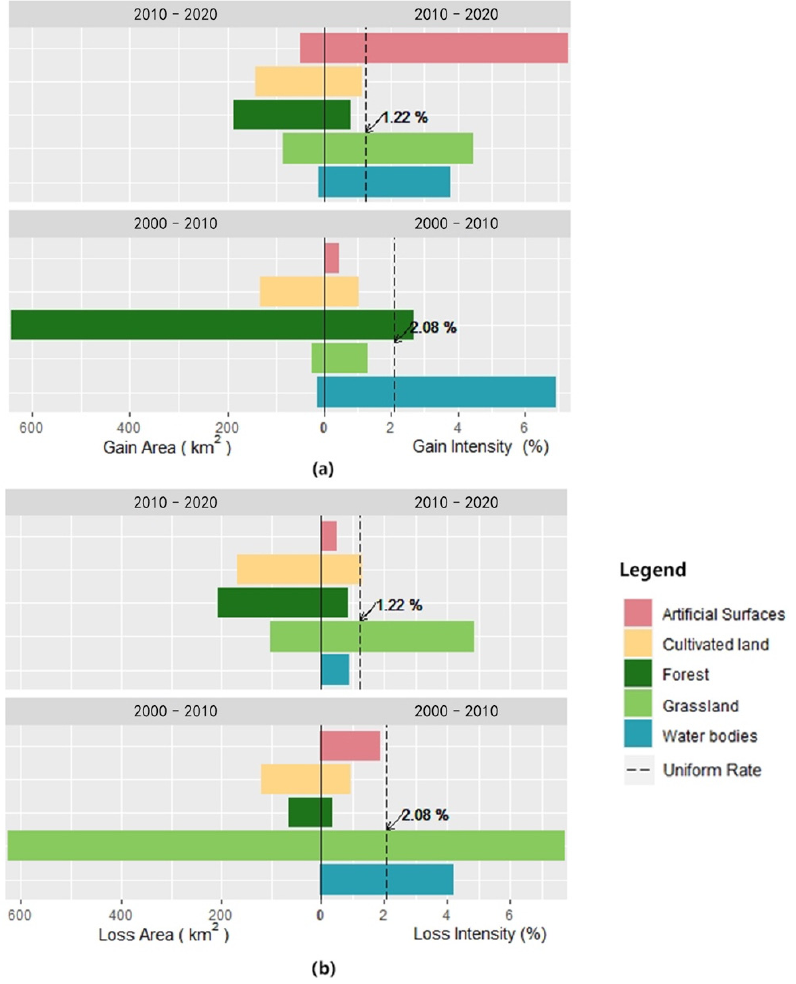
Figure 6. Intensity of change at the categorical level. Each bar plot combines the area of change (bars that extend to the left of zero) and intensity of change (bars that extend to the right of zero). ( a ) Gain intensity analysis for two time intervals: 2000–2010 and 2010–2020. ( b ) Loss intensity analysis for two time intervals: 2000–2010 and 2010–2020. If a category’s bar extends beyond the uniform line (the dash line), then the gain or loss of intensity is active. If a category’s bar ends before the uniform line, then the gain or loss of intensity is dormant.